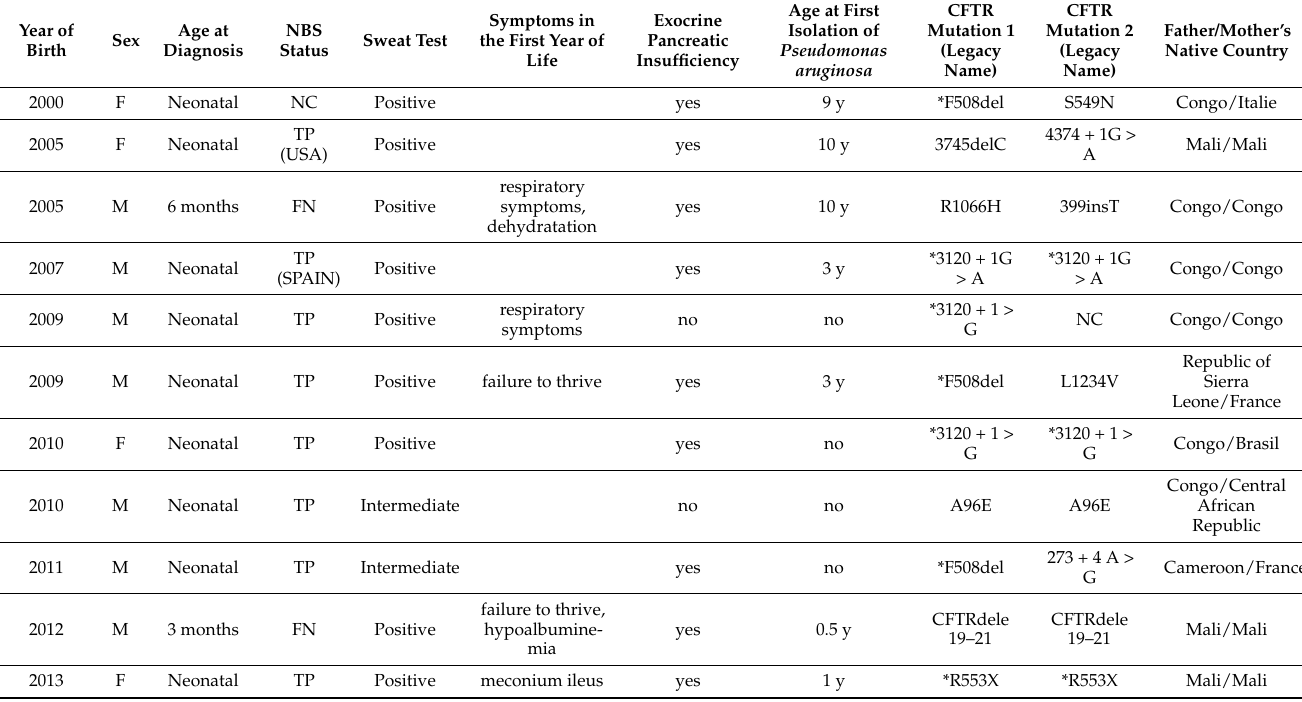
Table 1. Characteristics of children with at least one parent from WCA followed since